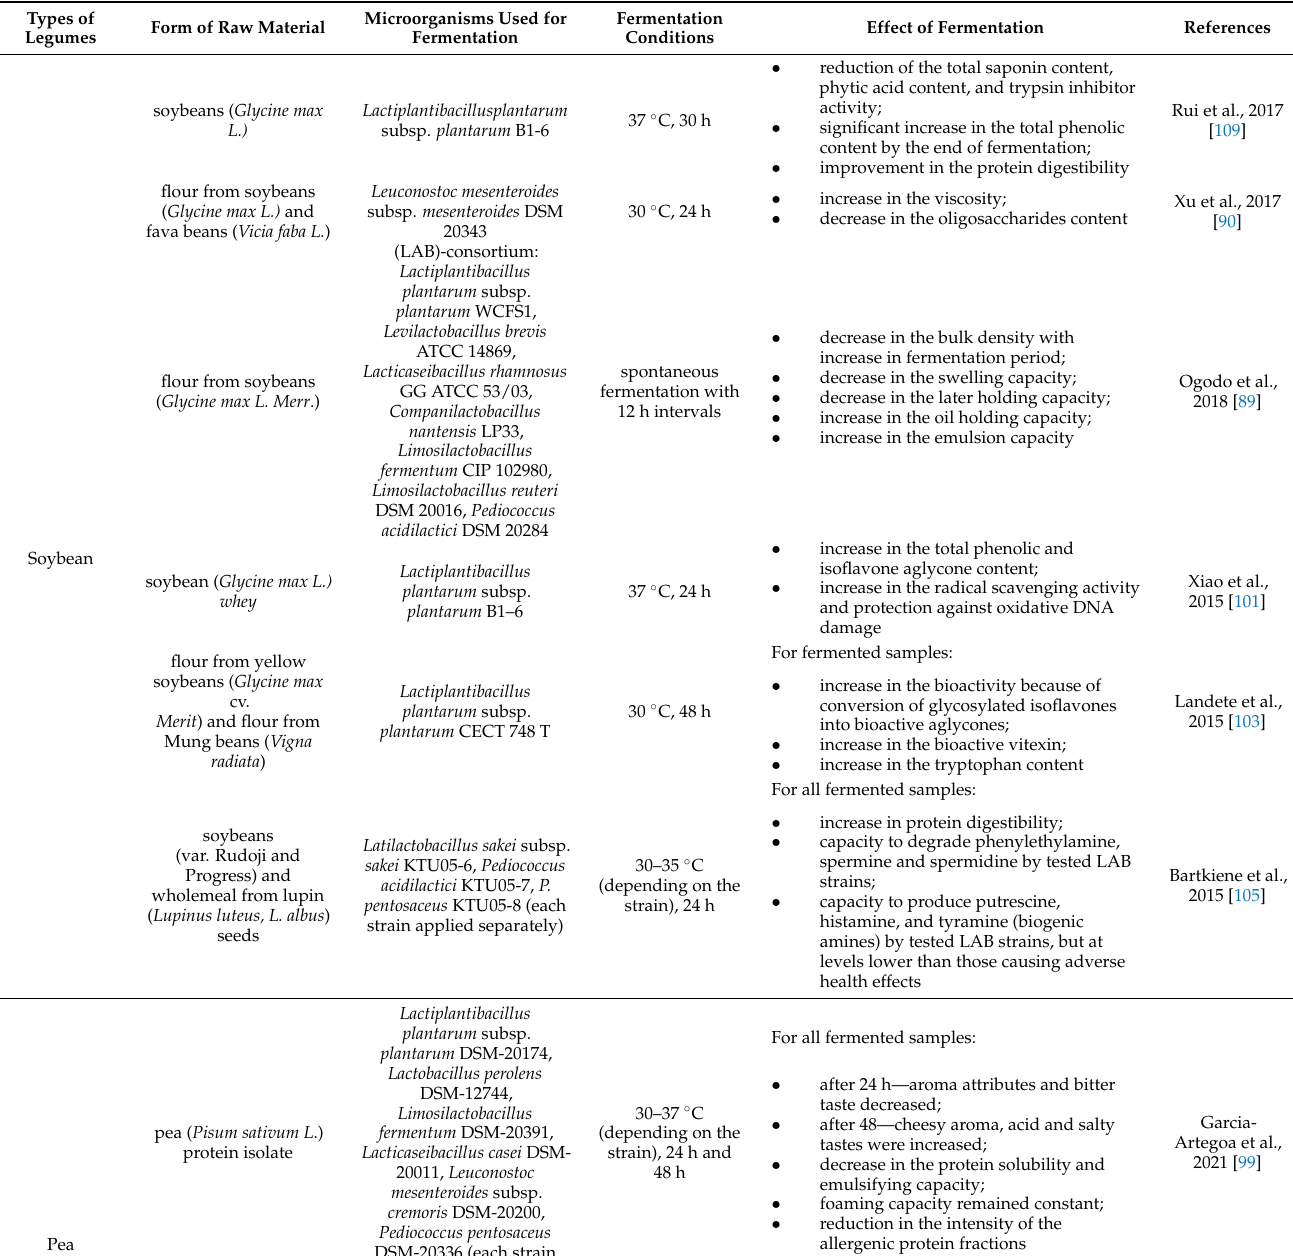
Table 4. The effect of fermentation with LAB on selected properties of